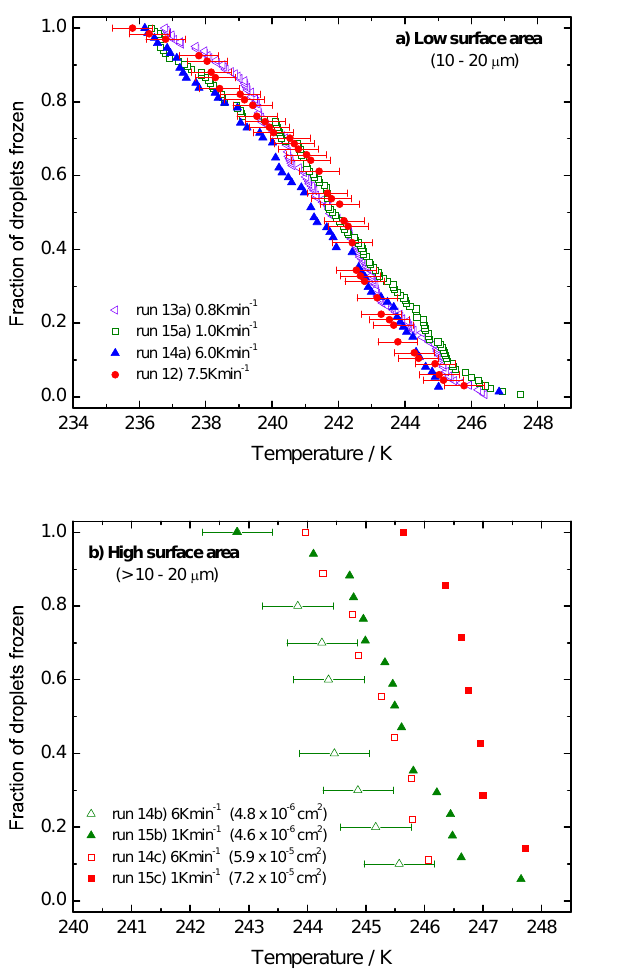
Fig. 6. (a) J(T ) as a function of cooling rate for droplets with con- centrations between 0.007wt% and 0.15wt% in the 10–20µm size bin (runs 1a–6a, 12a–17a, 1b-2b and 17b). For clarity, error bars are only shown for run 13a. The uncertainties in J(T ) were calculated using the uncertainties in surface area, based on the uncertainty in droplet volume combined with the uncertainty in the specific sur- face area of illite. (b) n s (T ) as a function of cooling rate for the same data as in panel a. For clarity, error bars are only shown for a few points in run 13a. The uncertainties in n s (T ) were also calcu- lated using the uncertainties in surface